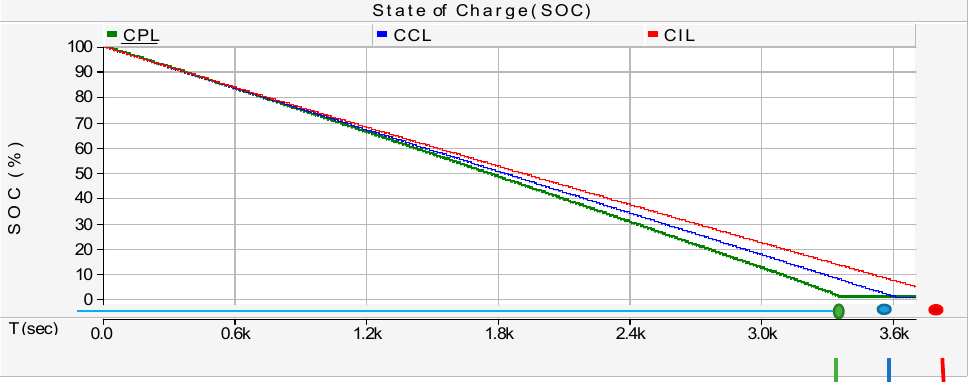
Figure 12. Battery runtime comparison for all modes of discharge.